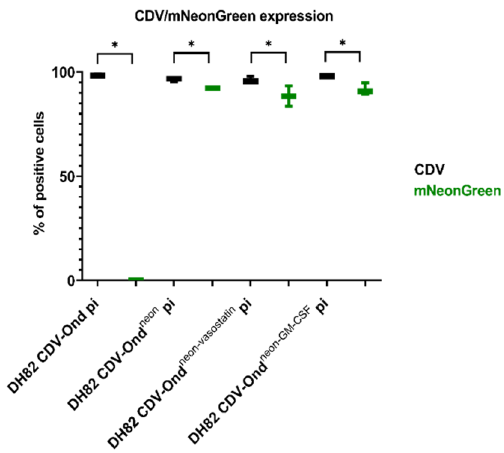
Figure 2. Statistical analysis revealed significant differences between the number of mNeonGreen- expressing and CDV nucleoprotein-immunopositive DH82 cells in cultures persistently infected with CDV-Ond, CDV-Ond neon , CDV-Ond neon-GM-CSF and CDV-Ond neon-vasostatin (Wilcoxon signed-rank test; p ≤ 0.05). Box plots represent minimum, median and maximum. Significant differences are labeled by asterisks * = p ≤